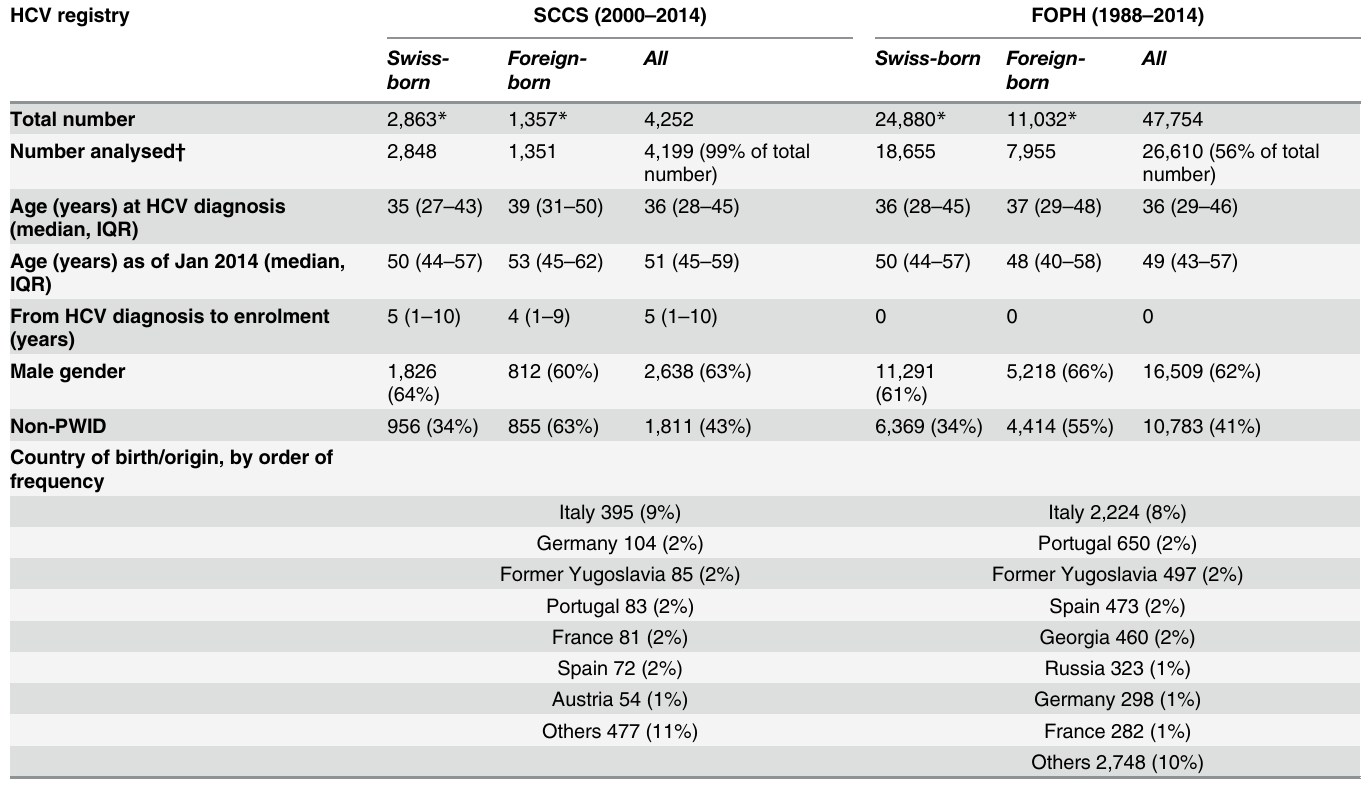
Table 1. Characteristics of persons with a HCV infection in the Swiss Hepatitis C Cohort Study (SCCS) and of cases mandatorily reported to the Federal Office of Public Health